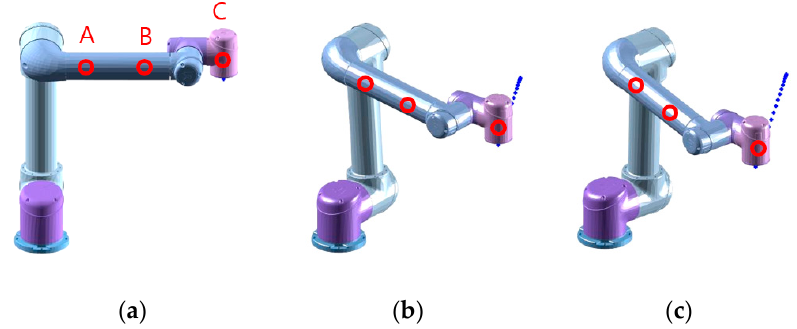
Figure 5. Simulation results: trajectory of the robot: γ = 0 ( a ), γ = 0.5 ( b ), γ = 1 ( c